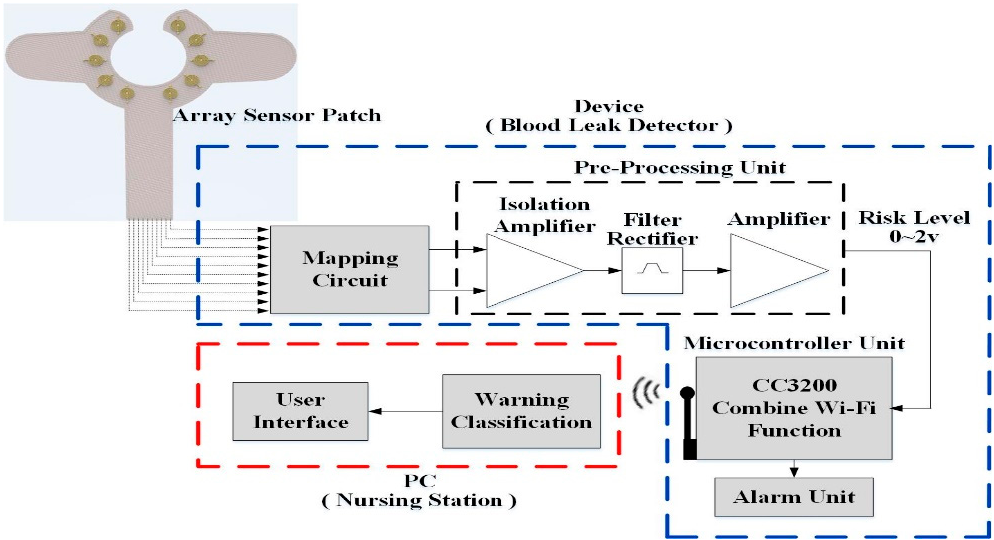
Figure 1 . System architecture. Figure 1. System